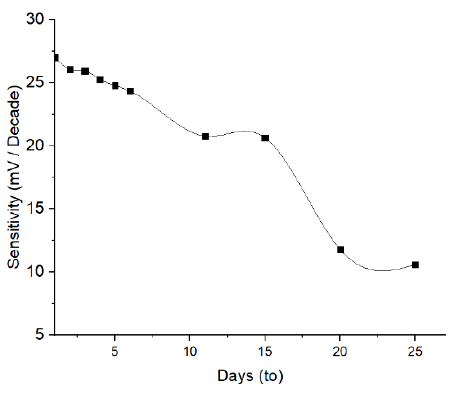
Figure 9. Lifetime of Pb 2+ ISE.